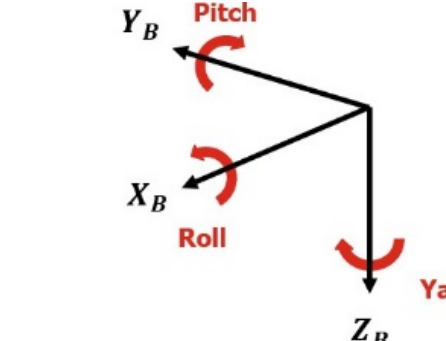
Figure 3. How to control a multi-copter using a twin stick controller. For gesture mapping suitable for the proposed gesture recognition-based UAVs con- trol, command lists were selected, as shown in Table 2, in consideration of the joystick- based multi-copter control command. Essentially, it consists of position control in the di- rection of roll, pitch, and yaw, and altitude control commands of the multi-copter. In ad- dition, Arming , Disarming , which additionally turns on/off the start of the aircraft motor, and the Stop command to stop the movement of the multi-copter and enter the hovering state, were selected. Take off and Land , which are instructions to take off and land the multi- copter, and Back home command to return the multi-copter to its initial takeoff point, were selected.